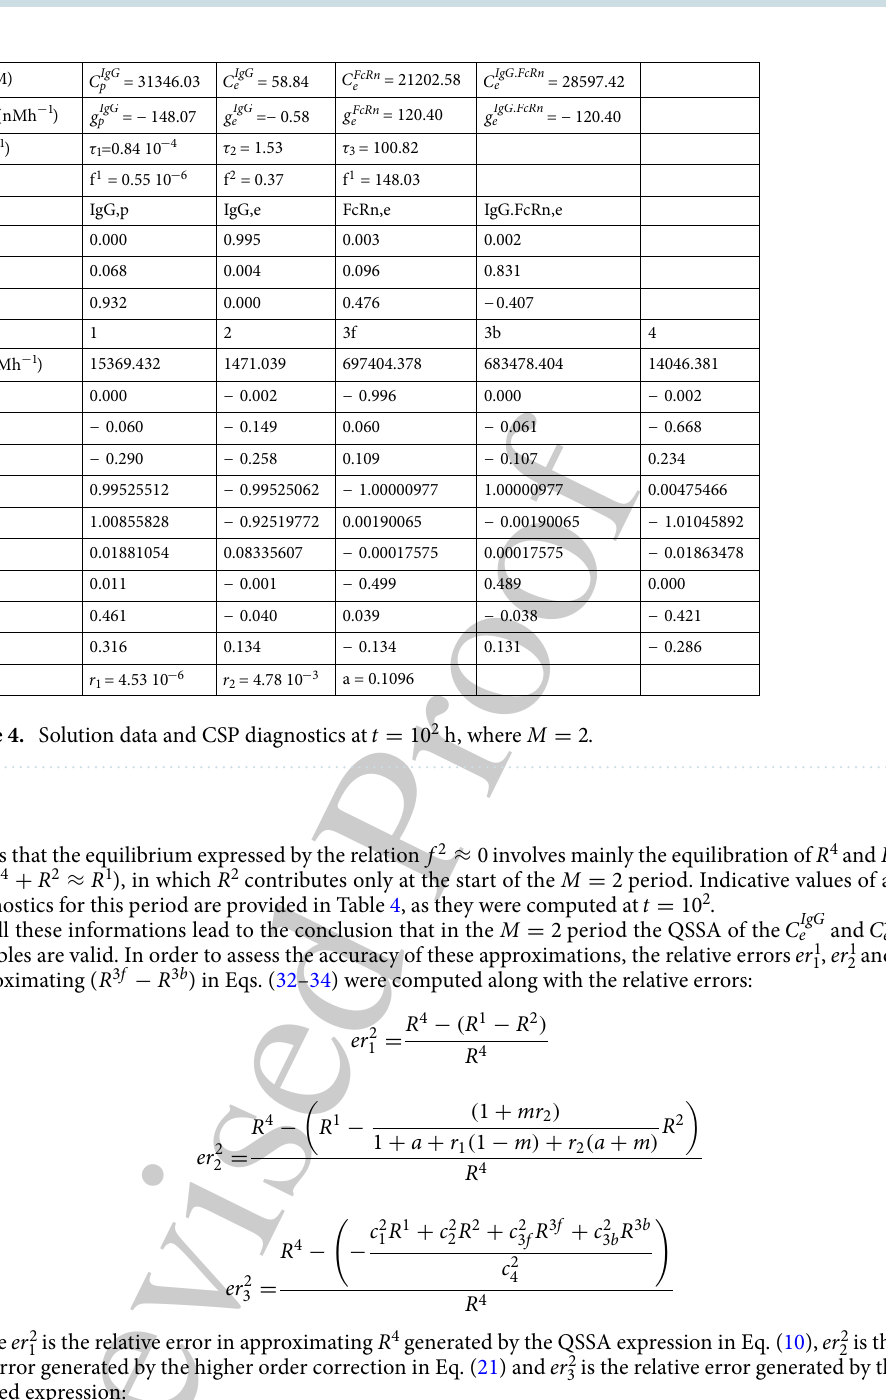
where er 2 1 is the relative error in approximating R 4 generated by the QSSA expression in Eq. (10), er 2 2 is the rela- tive error generated by the higher order correction in Eq. (21) and er 2 3 is the relative error generated by the CSP derived expression: